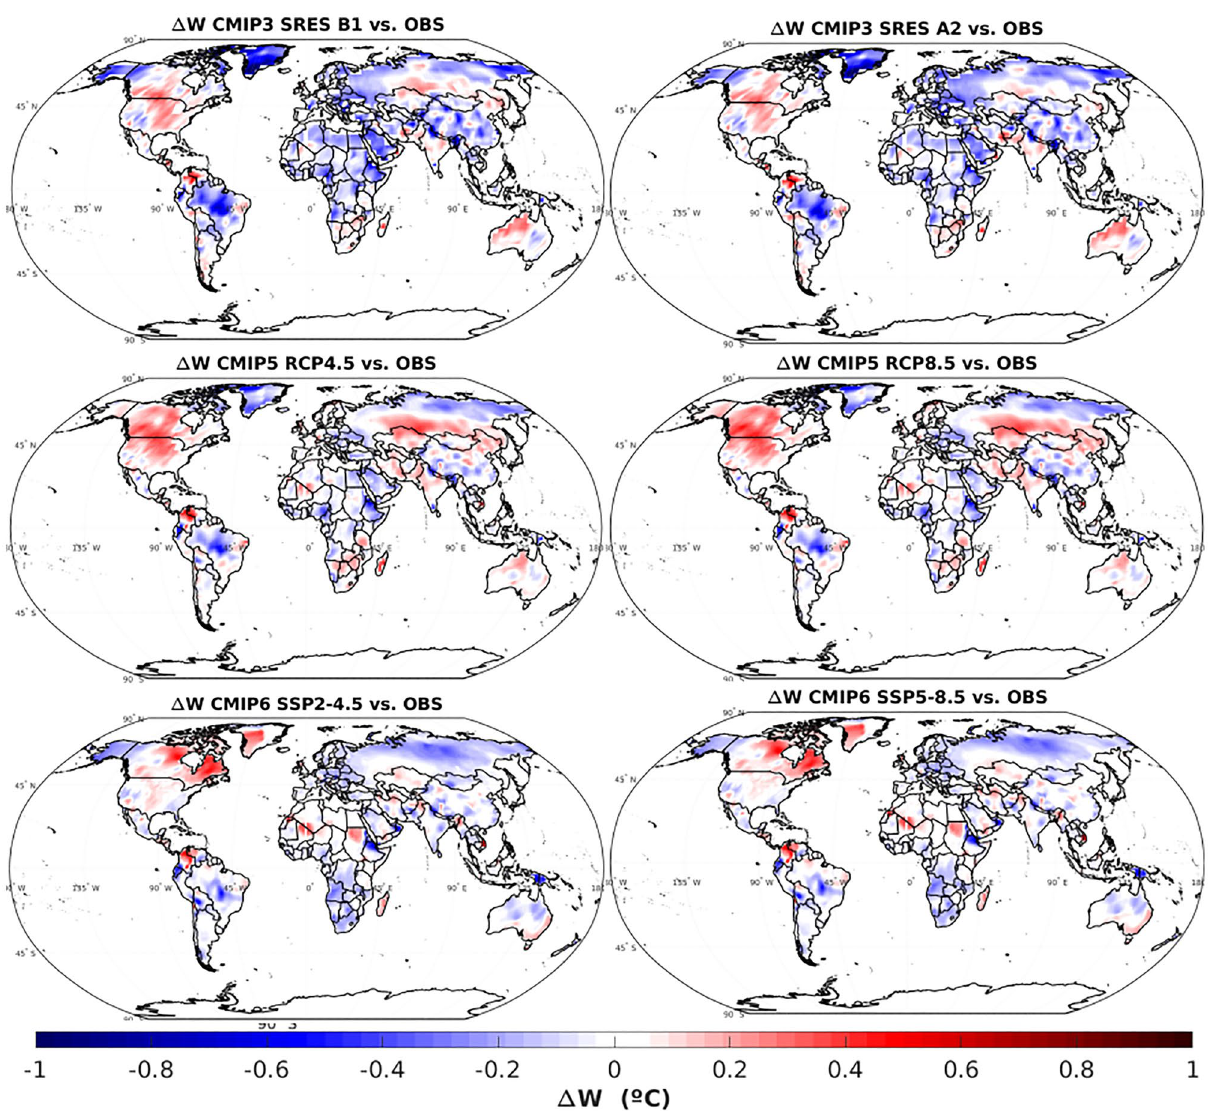
Figure 2. Spatial maps of the differences between the average warming projected by CMIPs and